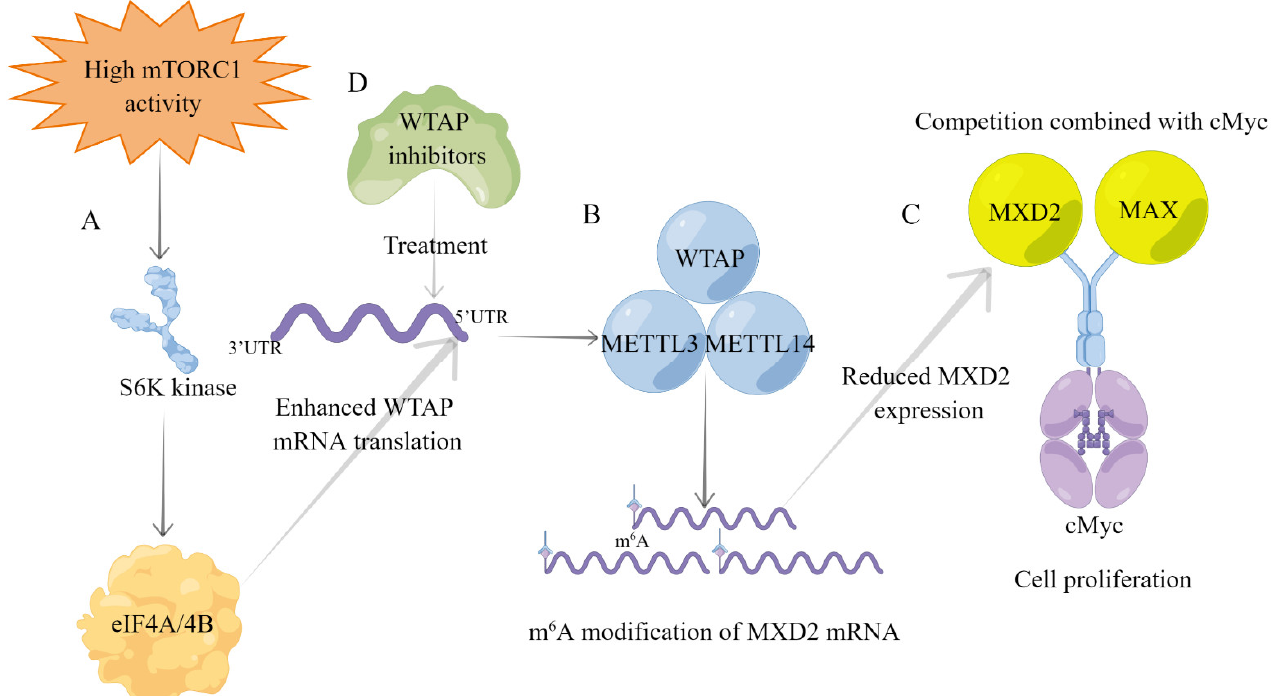
Figure 5. Overview of the mTORC1-WTAP-MXD2-cMyc axis for cancer progression. ( A ) Upregulation of mTORC1 signaling in tumors enhances WTAP mRNA translation via downstream S6K kinase. ( B ) The MMW complex reduces MXD2 expression by m 6 A modification of MXD2 mRNA. ( C ) MXD2 competes with MAX to bind cMyc. The decreased MXD2 expression leads to increased MAX binding to cMyc, thereby promoting tumor cell proliferation. ( D ) WTAP inhibitors inhibit WTAP expression and reduce MXD2 m 6 A modification, thereby inhibiting mTORC1 signaling to activate cancer cell proliferation.